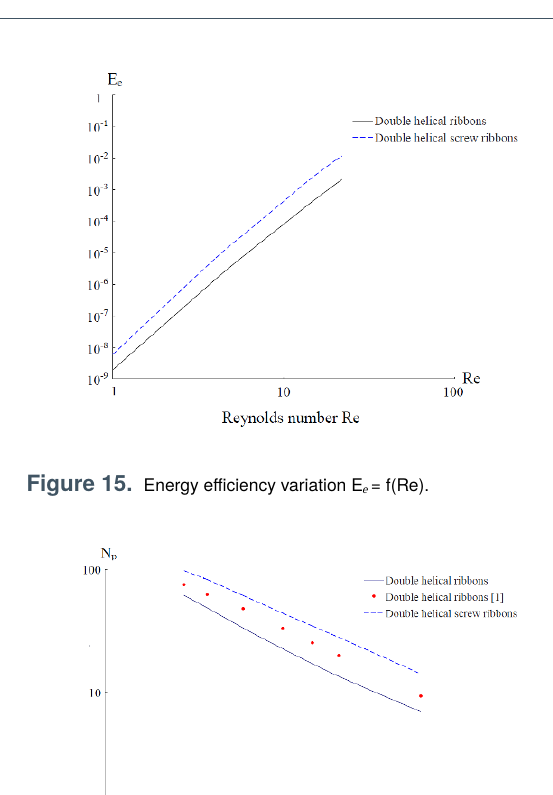
Figure 16. Power number variation N p =f(Re).